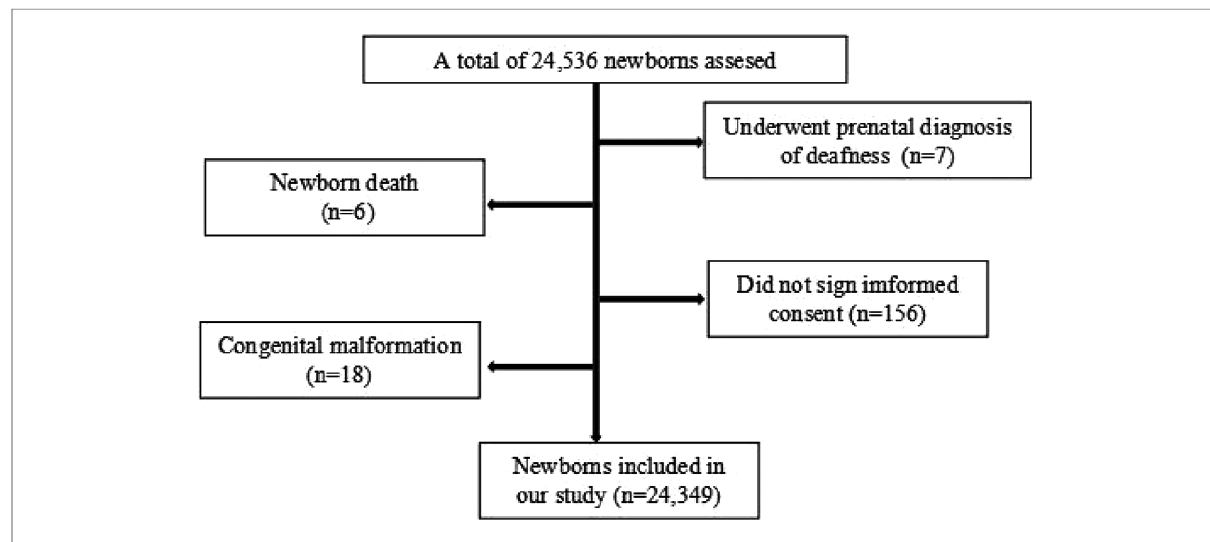
FIGURE 1 The fl ow diagram of the participants inclusion and exclusion in our